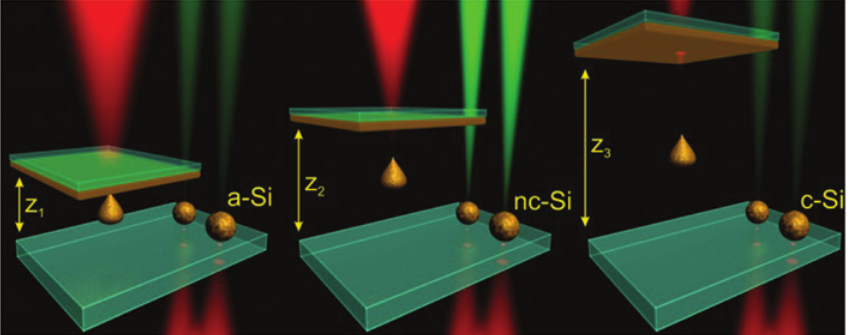
Figure 14: Schematic illustration of laser printing of silicon nanoparticles at different distances between donor (upper) and receiver (lower) substrates and the impact on their crystalline structure. The red beam represents the laser printing pulse while the green beams correspond to Raman measurement.